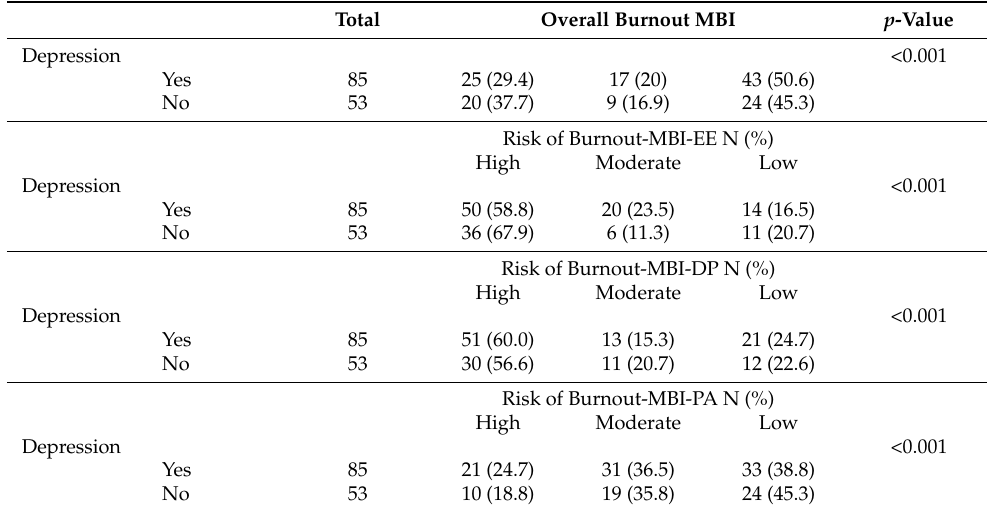
Table 4. Association between Respondent MBI Subscale Scores and